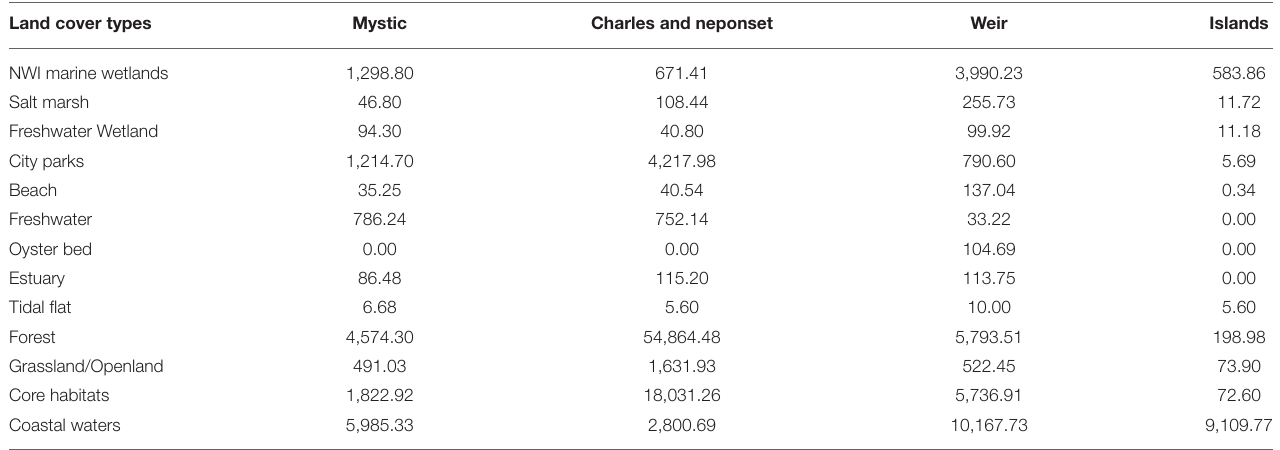
TABLE 3 | 2013 Land cover areas (acres) at MHHW by